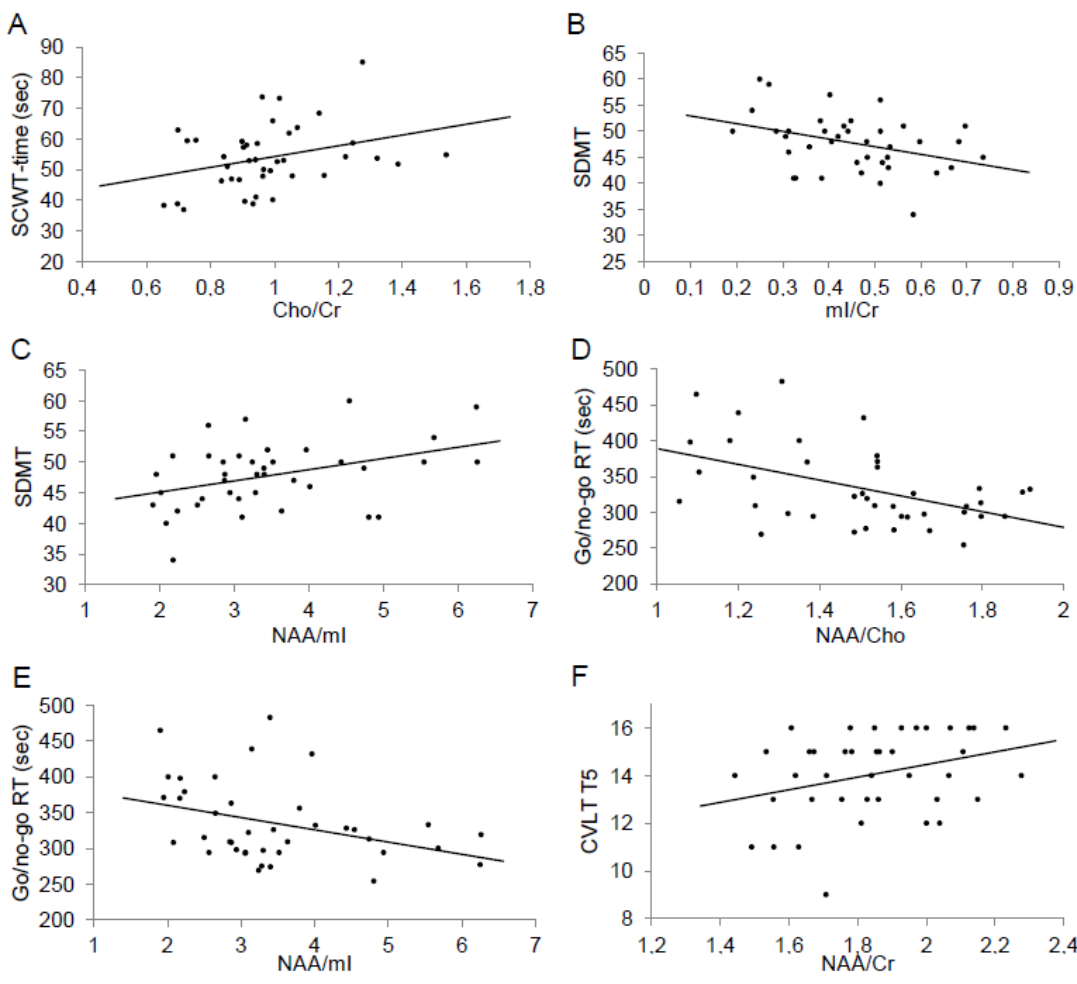
Figure 2. ( A – F ) Correlations between neuropsychological test scores and 1 H-MRS ratios in frontal